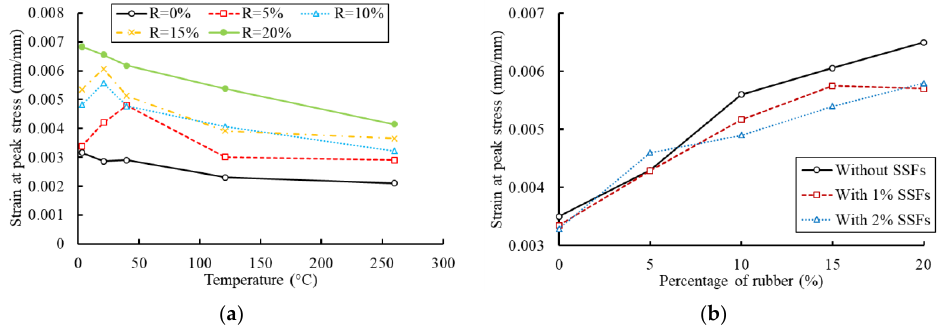
Figure 22. Strain at peak stress. ( a ) Effect of temperature. ( b ) Effect of SSFs.